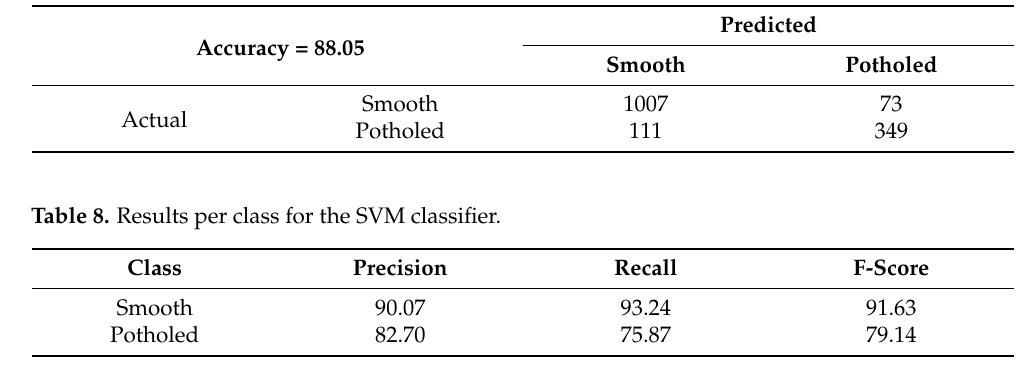
Table 7. Confusion matrix of the SVM classifier.